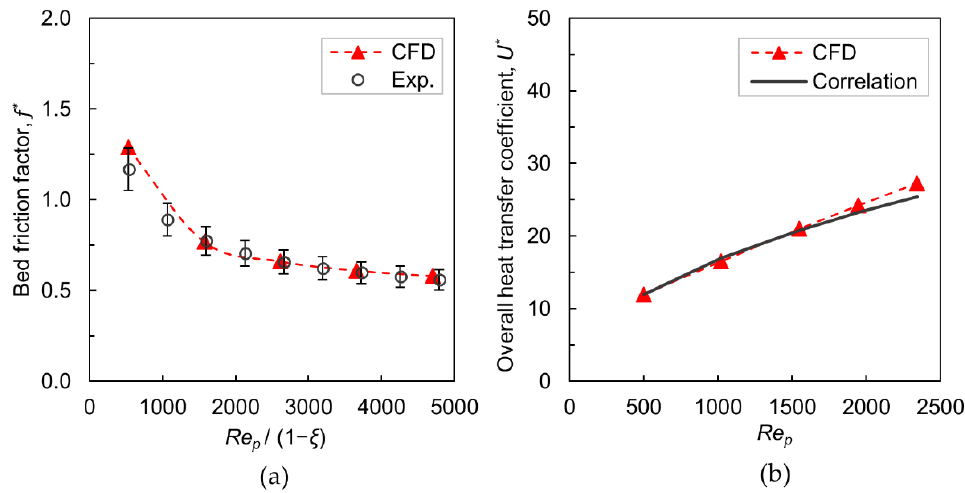
Figure 4. ( a ) Bed friction factor versus modified particle Reynolds number ( 𝜉 = ~0.40 is the mean interstitial bed voidage, experiment data from ref. [20] added with error bars of ± 10%); ( b ) Normalized overall heat transfer coefficient versus particle Reynolds number (correlation is Equation (19) from ref. [21]).